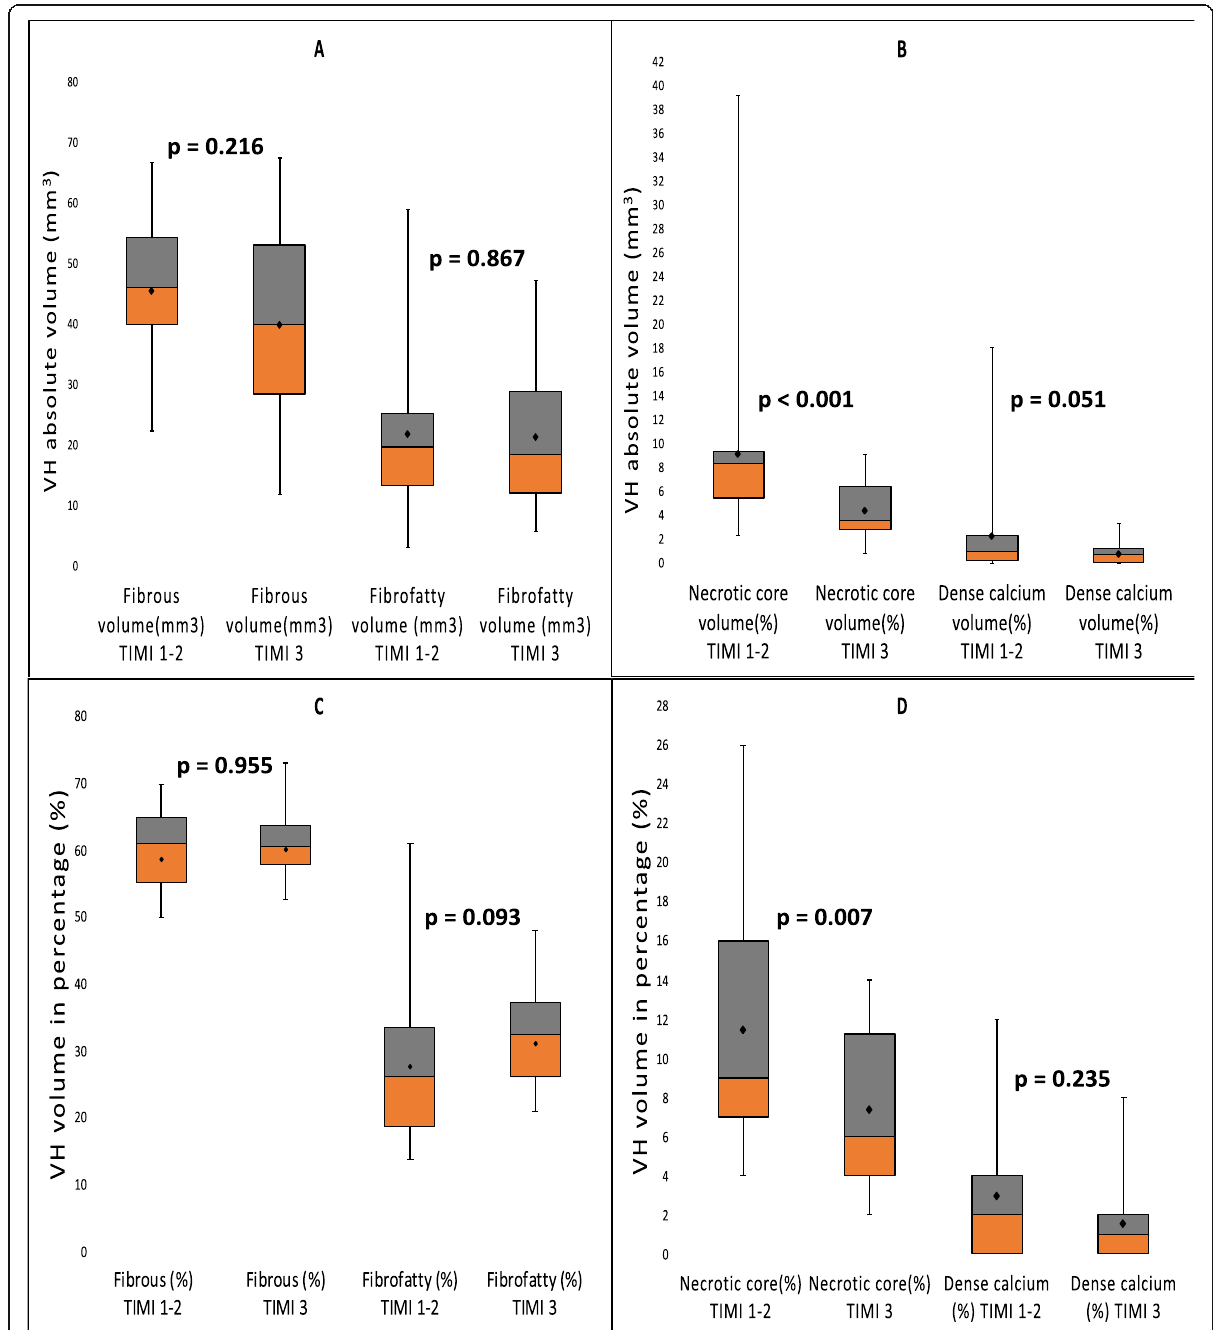
Fig. 2 The virtual histology plaque components in TIMI 1 – 2 and TIMI 3 groups over the segment. a , b The absolute volumes of the plaque components and c , d the relative plaque